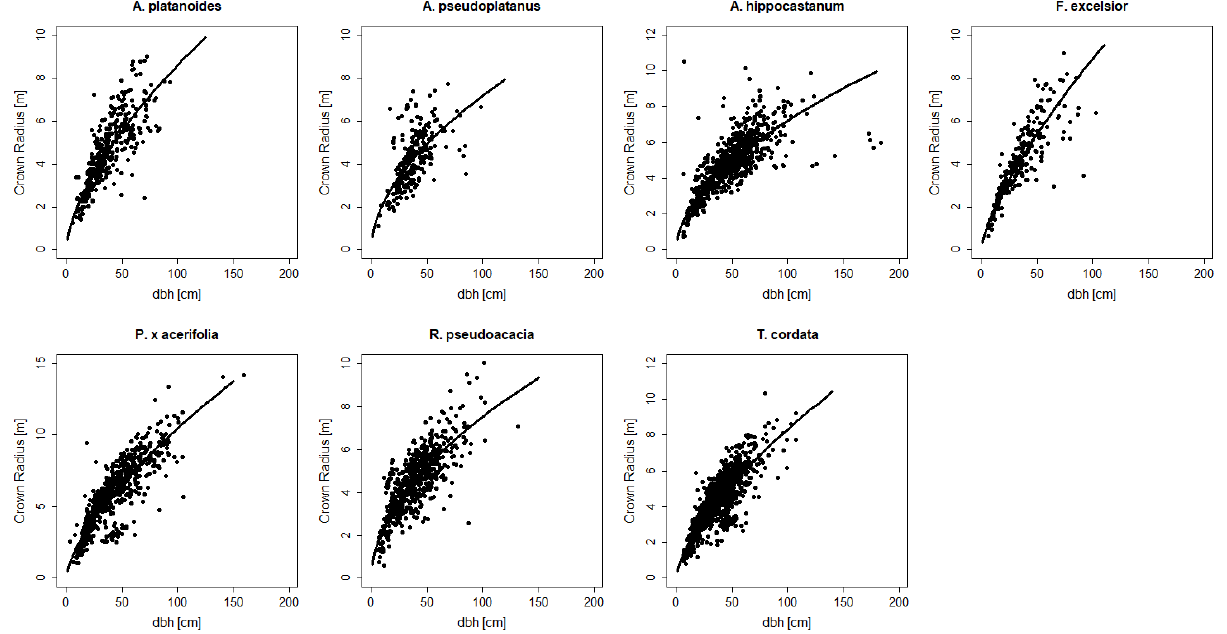
Figure 3. Crown radius and diameter at breast height relationship for seven common urban tree species. Table 4. Results of the transformed double-logarithmic equation detecting significance of changes in crown radius and crown length related to changes in